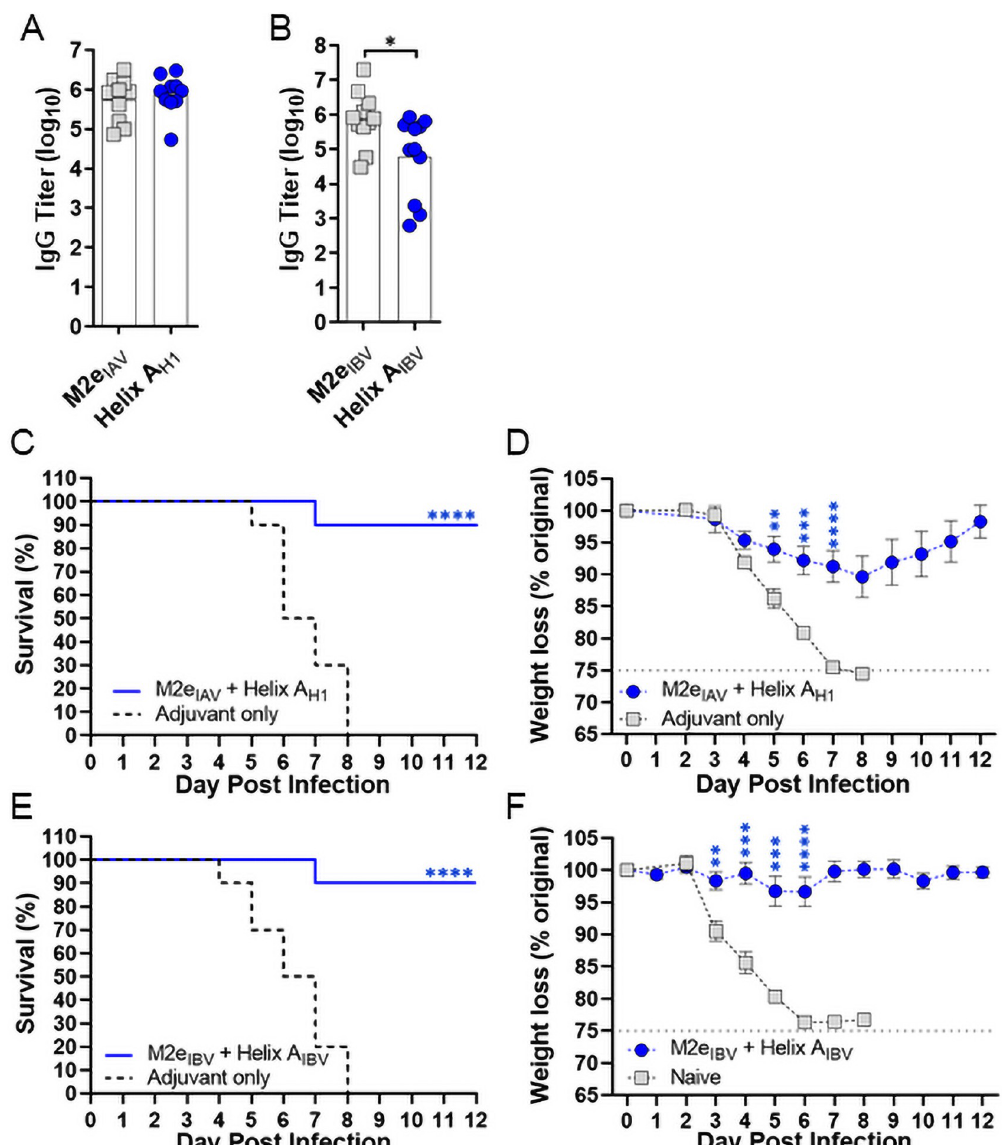
Fig 2. M2e + Helix A coformulations stimulate epitope-specific antibody responses to both targets and improve antiviral protection. CD-1 mice (n = 11) were immunized with ( A ) M2e IAV + Helix A H1 or ( B ) M2e IBV + Helix A IBV formulations (10 μ g/peptide) in GLA-SE and d35 sera was assayed for antibody titers by ELISA. Statistical differences were calculated with an unpaired two-tailed t-test ( � P < 0.05). On d42, mice were challenged with ( C , D ) A/California/07/2009 or ( E , F ) B/Florida/ 04/2006 and then monitored for survival and weight loss plotted as mean ± S.E.M. Survival curves were compared by log-rank Mantel-Cox test. Data from each weight loss time point were compared by one-way ANOVA followed by unpaired two-tailed t-test. Asterisks denote significance between control and indicated test group. For weight loss, significance over the control is shown until maximum difference ( �� P < 0.01, ��� P < 0.001, ���� P < 0.0001).